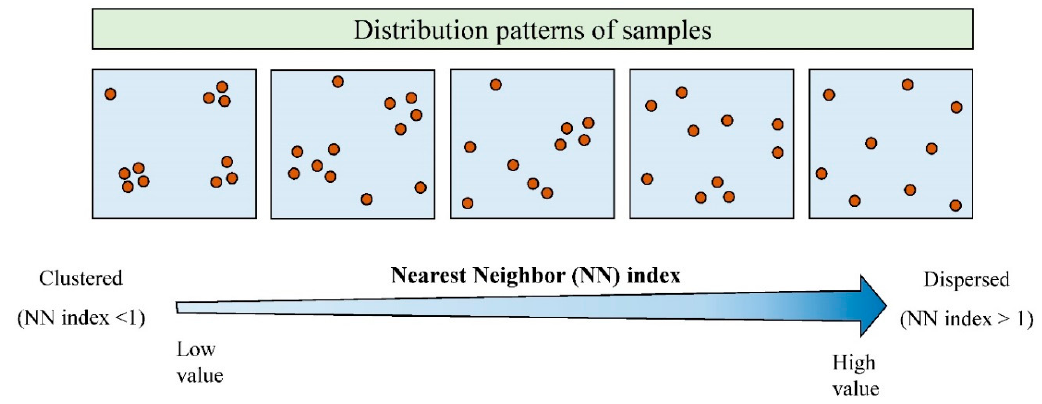
Figure 2. Schematic diagram of the relationship between the distribution pattern of samples and the nearest neighbor (NN) index.